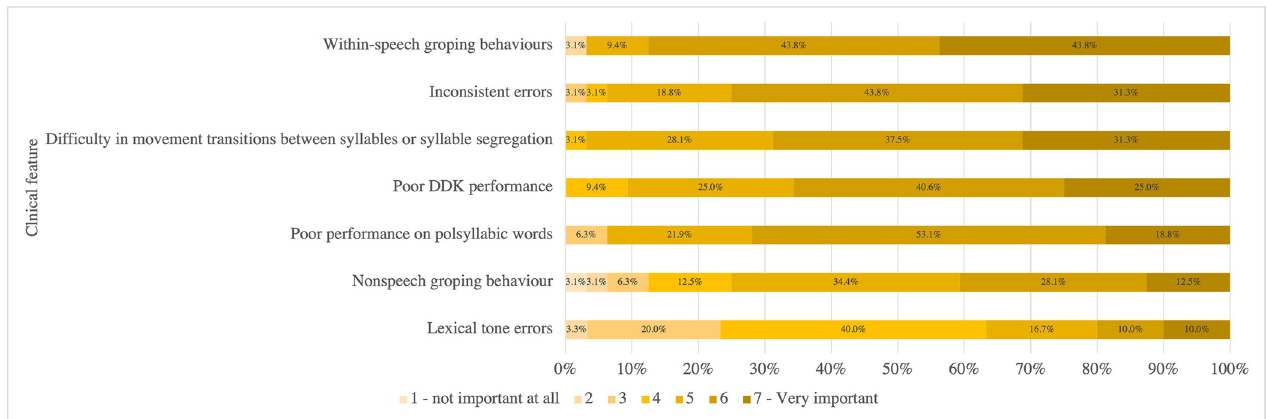
Fig 6. Distribution of ratings of seven clinical features for making a differential diagnosis of childhood apraxia of speech.